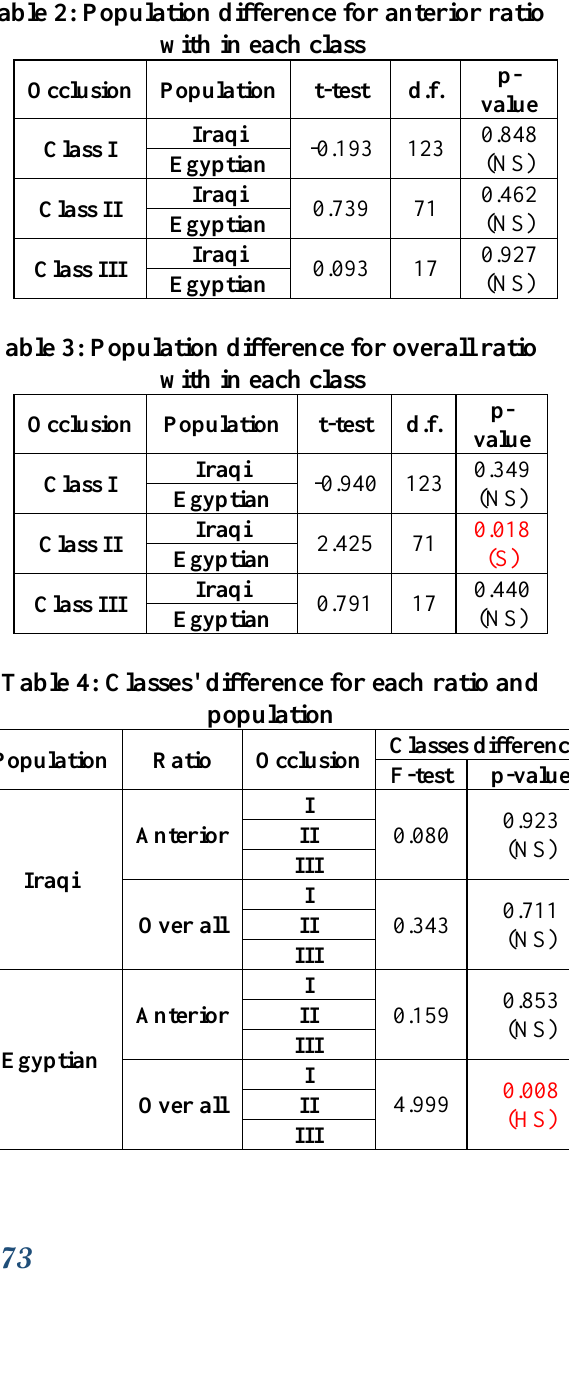
Table 2: Population difference for anterior ratio